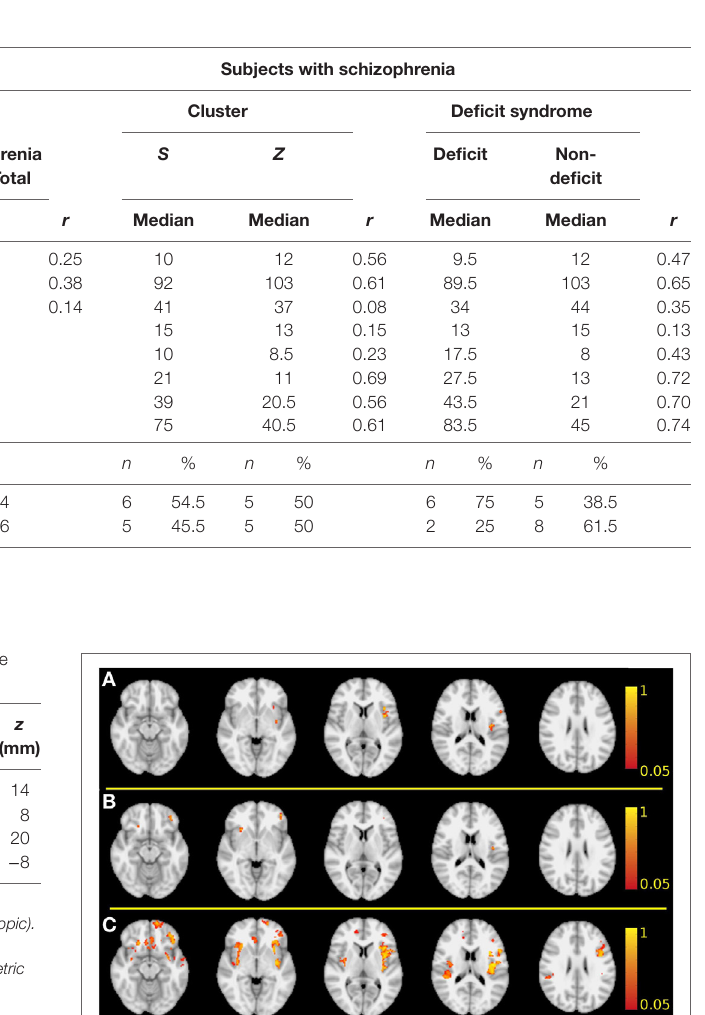
FigUre 1 | Significant gray matter deficits in schizophrenia patients. Row (a) the whole, mixed group of patients with schizophrenia compared to the healthy controls. Row (B) the deficit group compared to the healthy controls. Row (c) the cluster S compared to the healthy controls. Red-to-yellow volumetric clusters indicate p values between 0.05 and 1, corrected for multiple comparisons. In all three comparisons, the same slices are presented at z -coordinates indicated at the bottom of the figure.